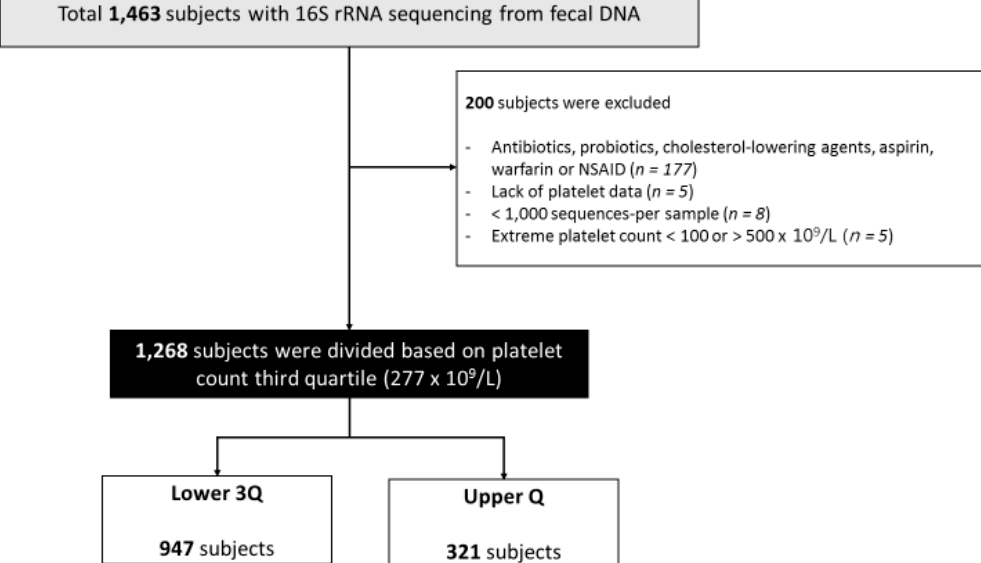
Figure 1. Flowchart of subjects’ enrollment. NSAID, non-steroidal anti-inflammatory drugs; Lower 3Q, <75th percentile for platelet count; Upper Q, ≥ 75th percentile for platelet count.